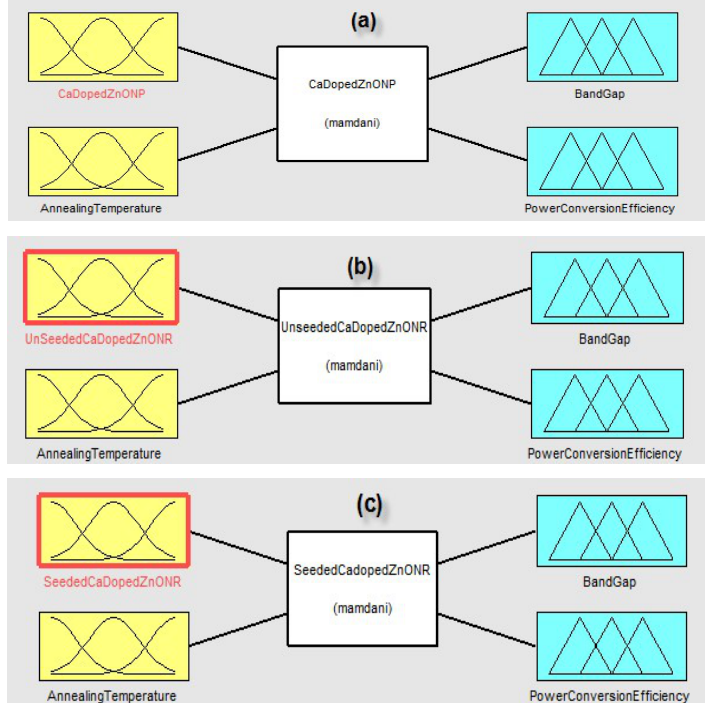
Figure 2. FIS figure for ( a ) Ca‐doped ZnO nanoparticles (NP) and ( b ) Unseeded Ca‐doped ZnO nanorods (NR) ( c ) Seeded Ca‐doped ZnO NR .